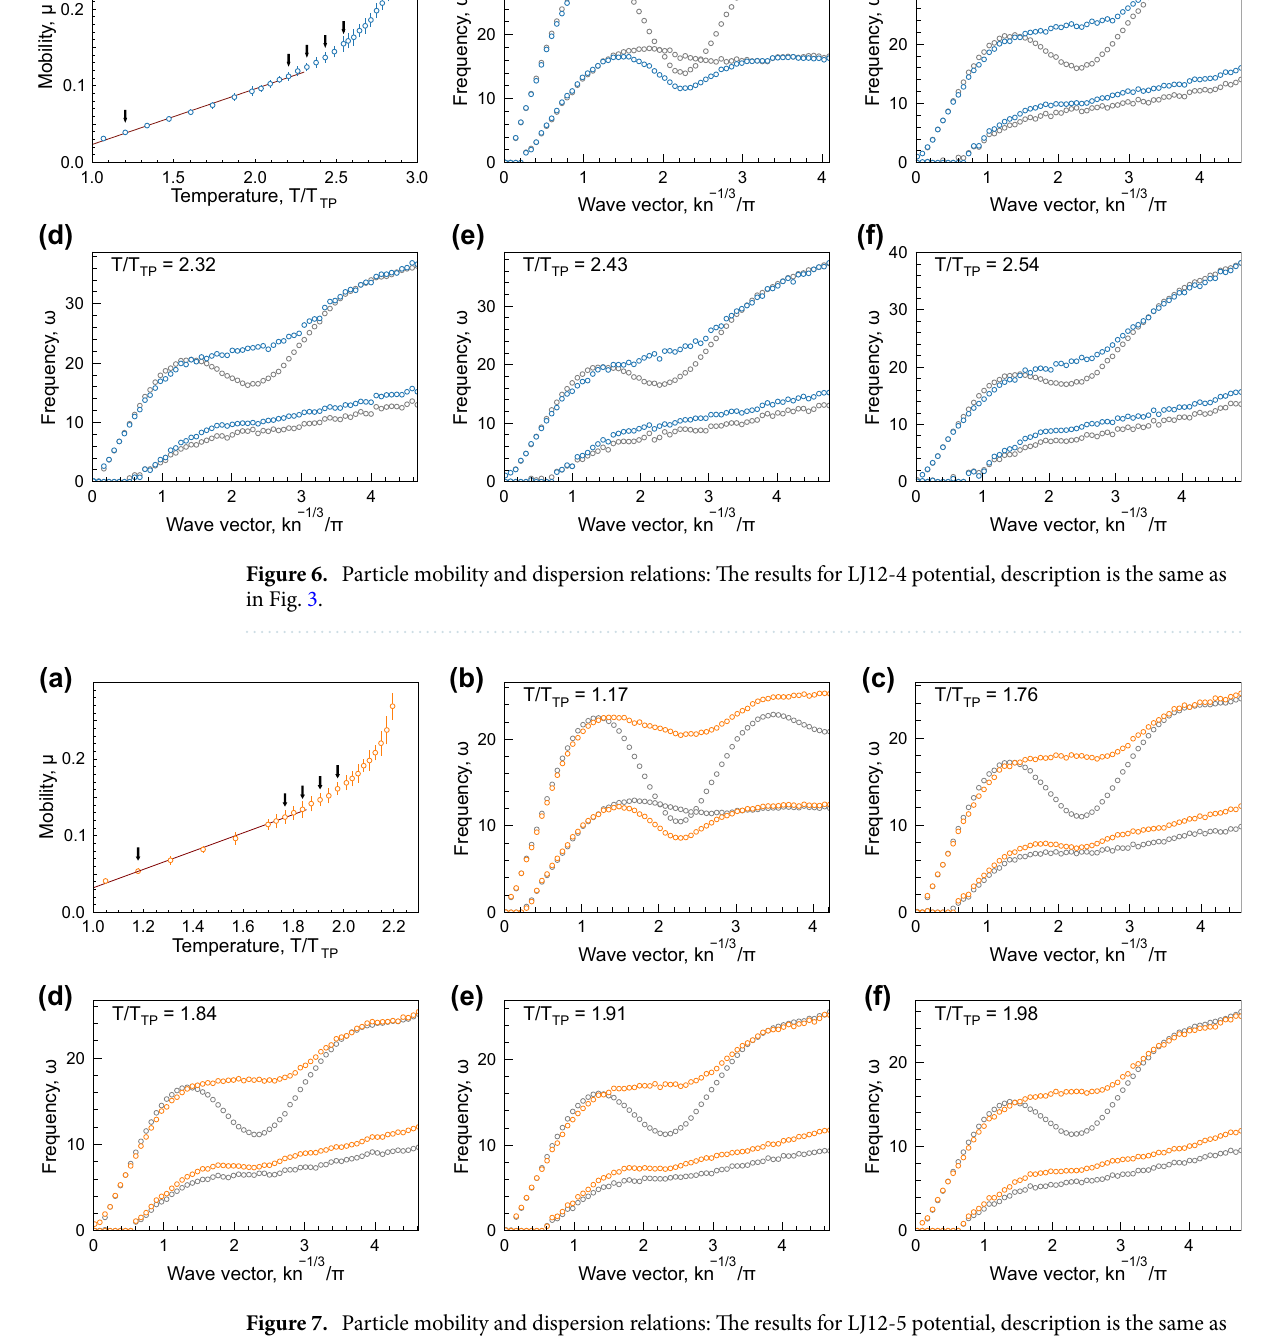
Figure 7. Particle mobility and dispersion relations: The results for LJ12-5 potential, description is the same as in Fig.